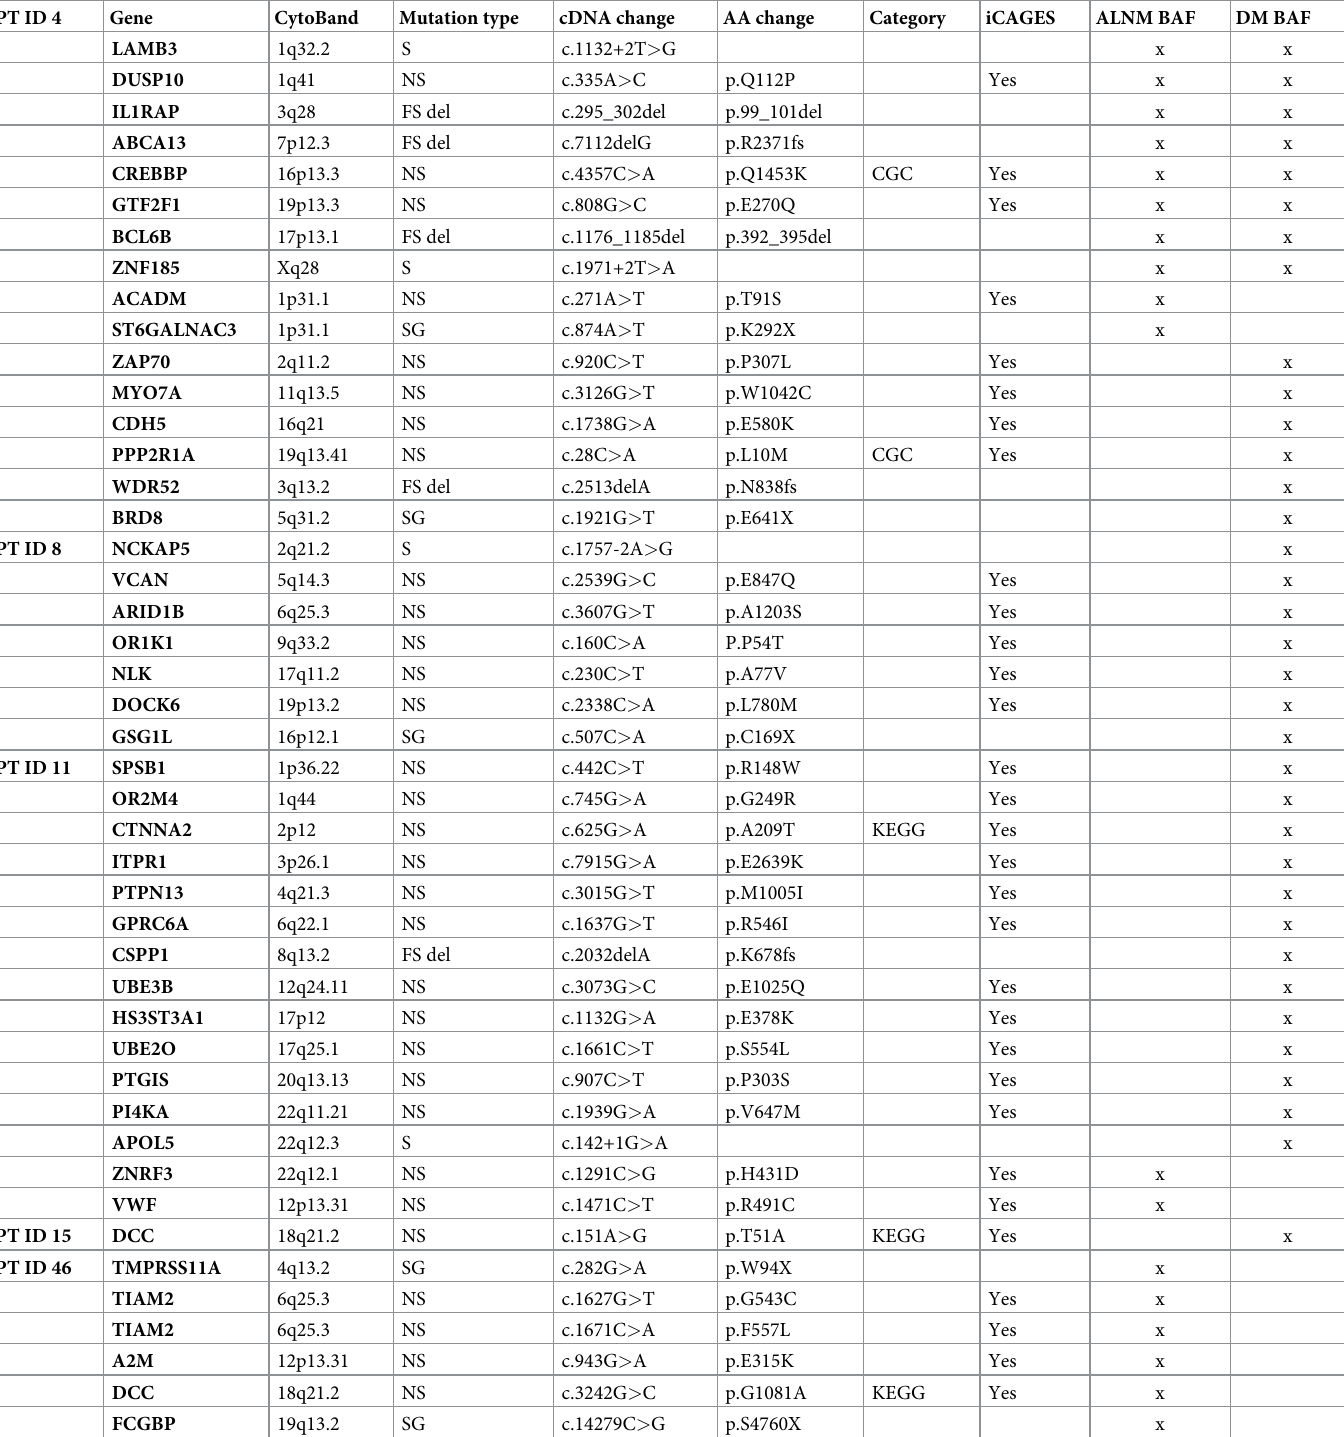
Table 9. Putative drivers of metastatic progression from Category 3, metastasis specific